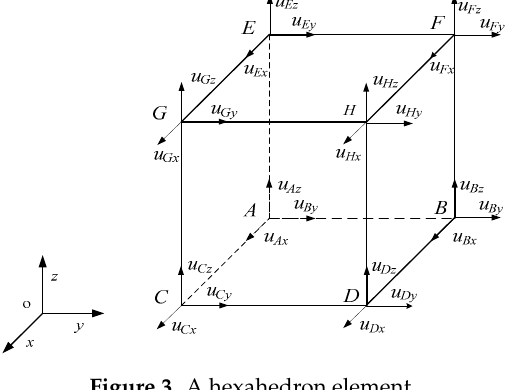
Figure 3. A hexahedron element.